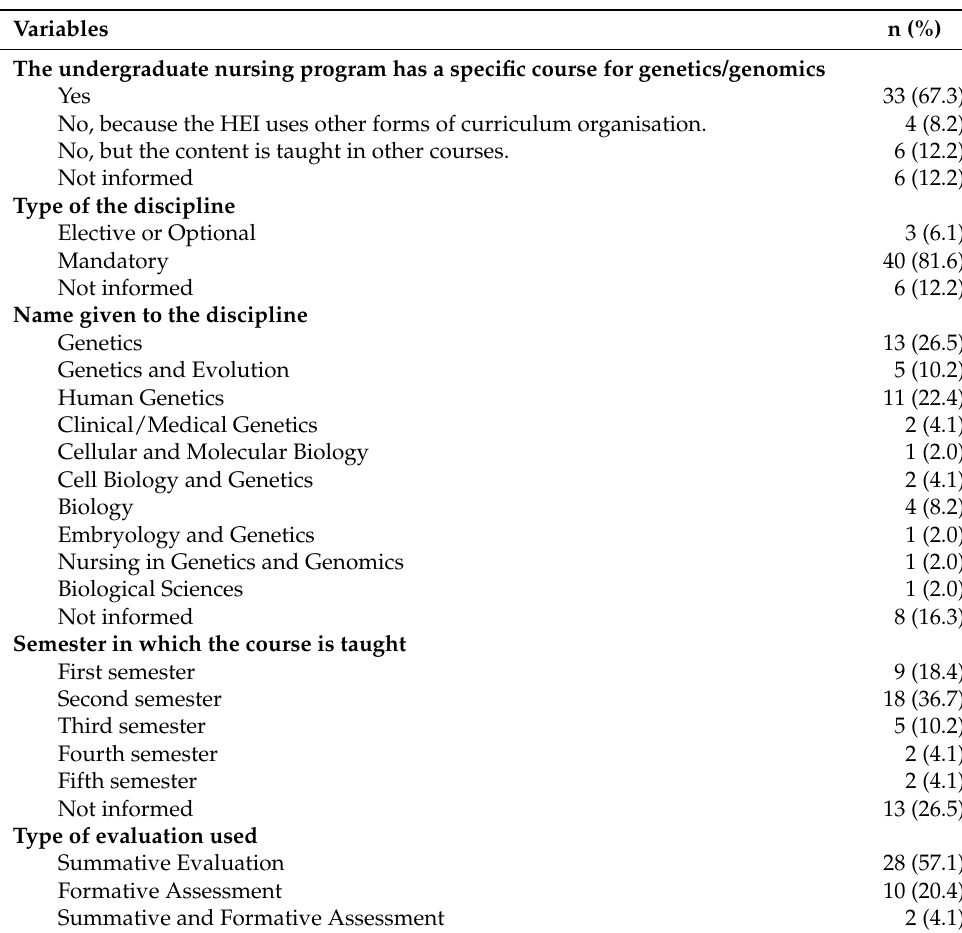
Table 4. Description of the curriculum organization and teaching-learning strategies of the genetics and/or genomics course.